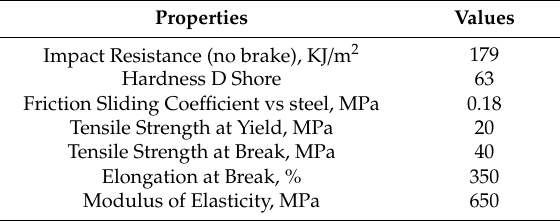
Table 8. Properties of the material used by the “Polytech Plastics Australasia”.